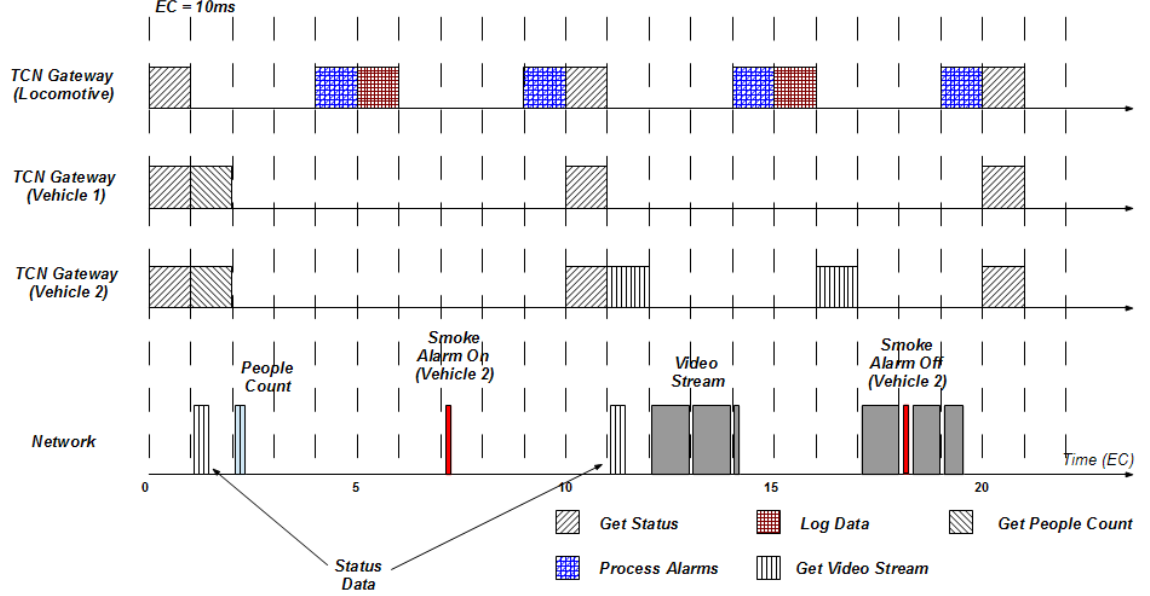
Figure 9. Simulation results for a train including a locomotive and two passenger